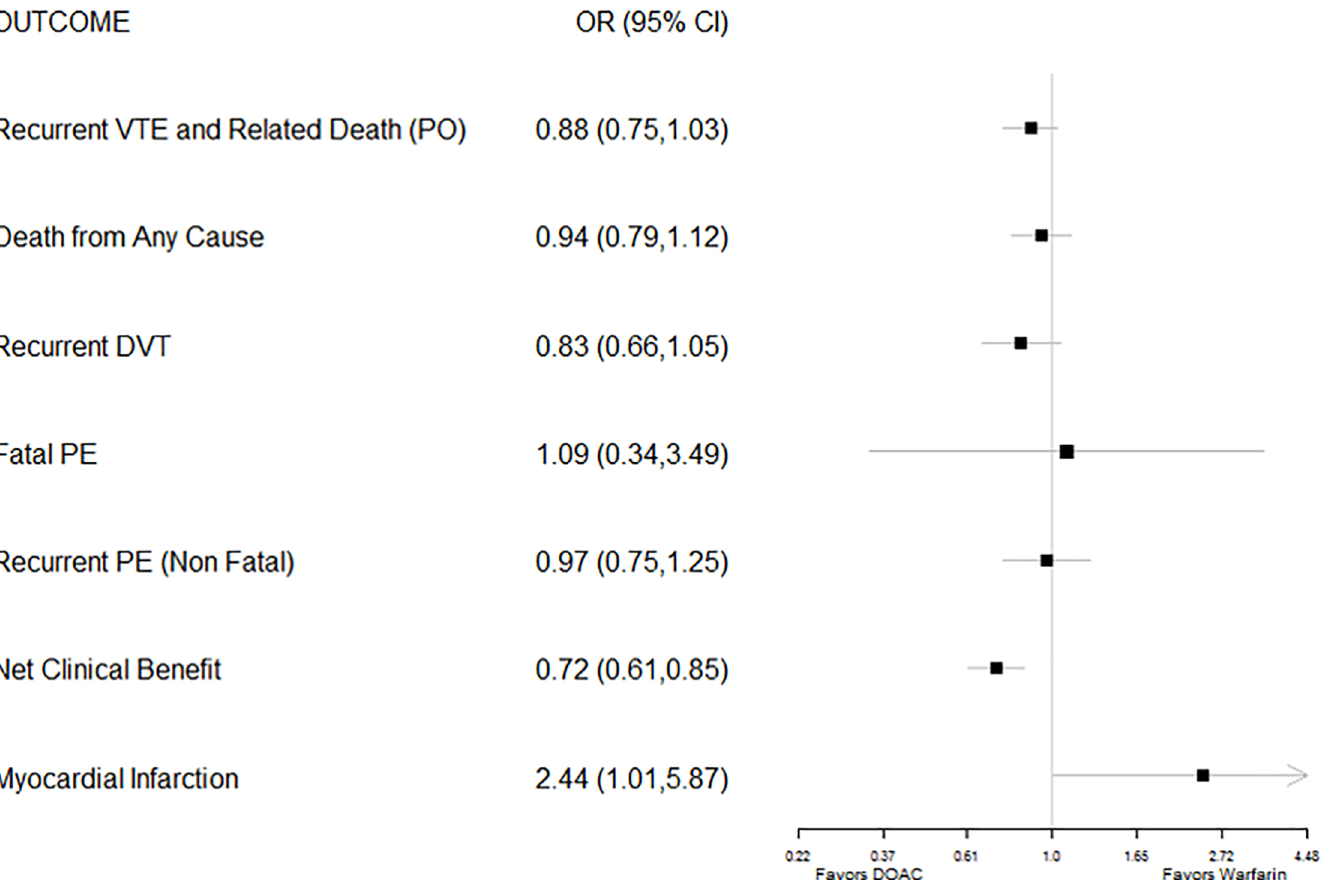
Fig 4. Forest plot of pooled odds ratios (with 95% CI) of various efficacy outcomes for FDA-approved direct oral anticoagulants versus warfarin for treatment of VTE.